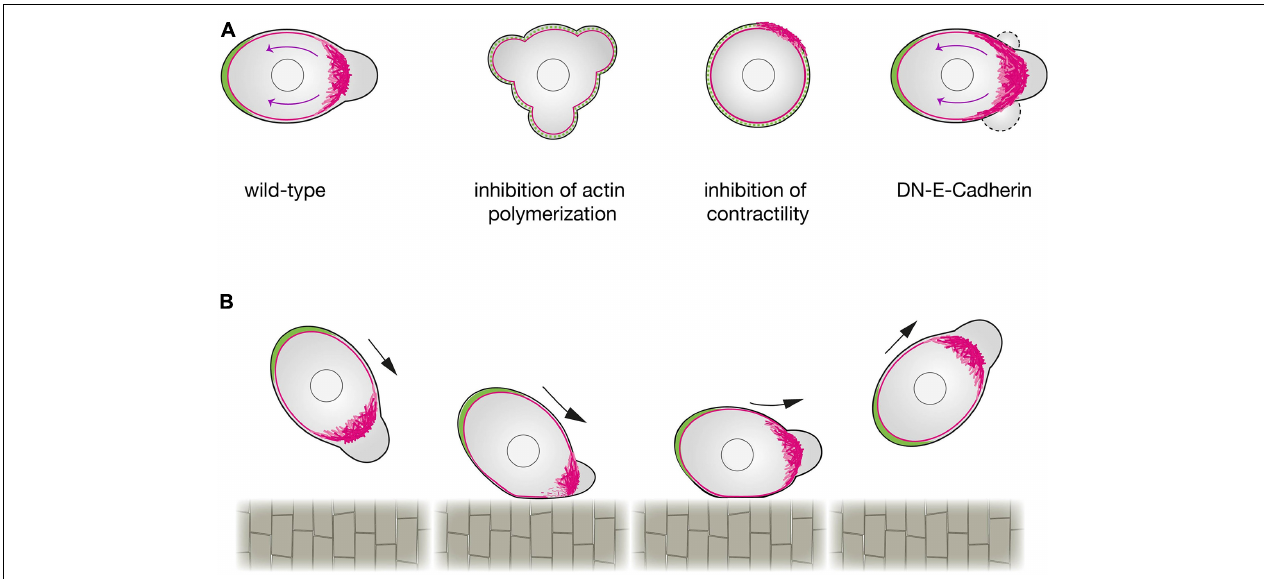
FIGURE 2 | Regulation of zebrafish primordial germ cells polarization. (A) A schematic representation of a wild-type PGC (left) compared with a PGC in which actin polymerization (center left), contractility (center right) or cell-cell adhesion (right) are inhibited. Upon a reduction in actin polymerization (by inhibition of Rac1 activity), PGCs cannot form a cell front and polarity is not established. When contractility is blocked (e.g., by inhibition of ROCK activity), PGCs can generate actin brushes, but the cell rear is not defined. When E-Cadherin mediated cell-cell adhesion is inhibited, the actomyosin retrograde flow is enhanced, expanding the area of the cell front where blebs form. Retrograde actin flow is marked by magenta arrows. (B) The effect of contact with a barrier on PGC polarity. PGCs that make contact with the notochord at intermediate or steep angles exhibit a reflective behavior. A reduction in the actin brushes concentration at the side of the cell interacting with the barrier is observed, while the unaffected actin brushes at the opposite side define the new front that directs the migration away from the barrier.